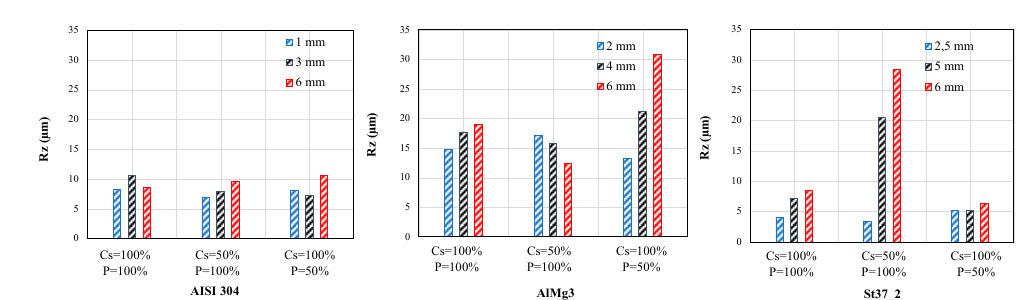
Figure 19. Arithmetic mean surface roughness. Figure 20. AISI 304 kerf lateral surface: ( a ) 6 mm, Cs = 50% P = 100%; ( b ) 3 mm, Cs = 50% P = 100%; ( c ) 3 mm, Cs = 100% P = 100%.